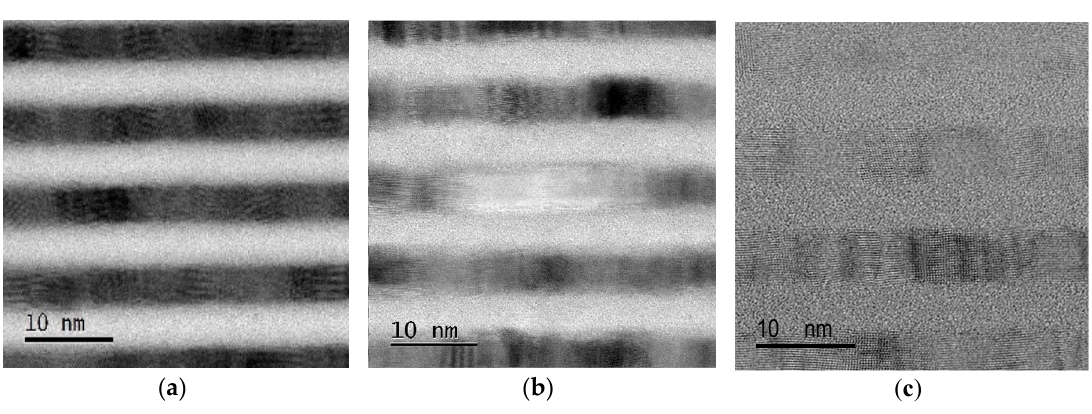
Figure 1. Cross-sectional (bright field) HRTEM images of multilayered films with the ratio of thicknesses of MeN (darker contrast) and SiN x (brighter contrast) elementary layers equal to 5 nm/5 nm: ZrN/SiN x ( a ); CrN/SiN x ( b ); and AlN/SiN x ( c ).